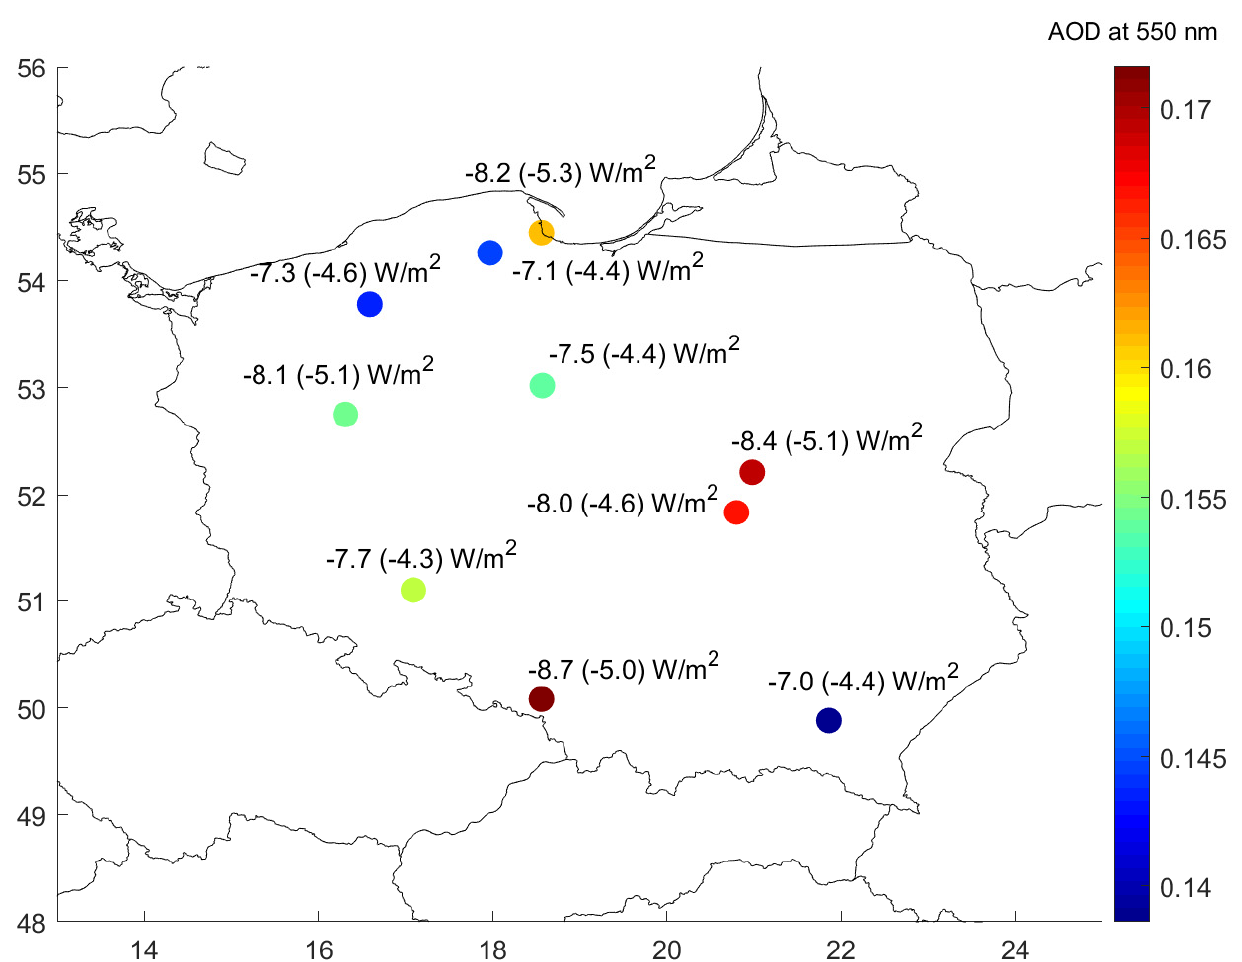
Figure 4. Spatial distribution of 2011–2019 mean AOD at 550 nm (colour scale) and surface and TOA (in parenthesis) ARF in W/m 2 at Poland-AOD stations.